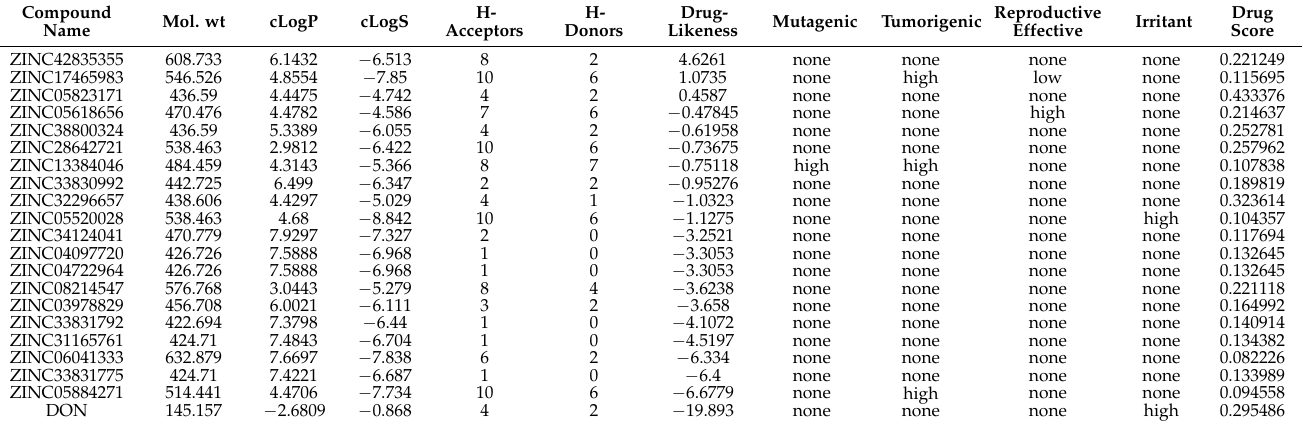
Table 1. Top 20 screened compounds with their physicochemical and drug-likeness properties.